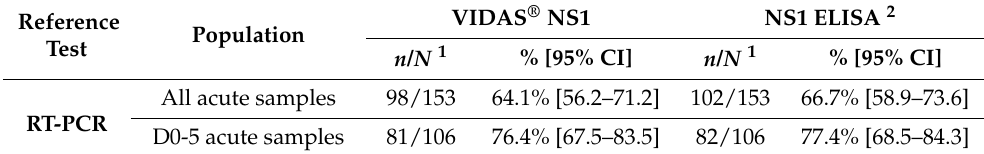
Table 7. Positive agreement of the VIDAS ® and competitor ELISA NS1 antigen assays with RT-PCR.